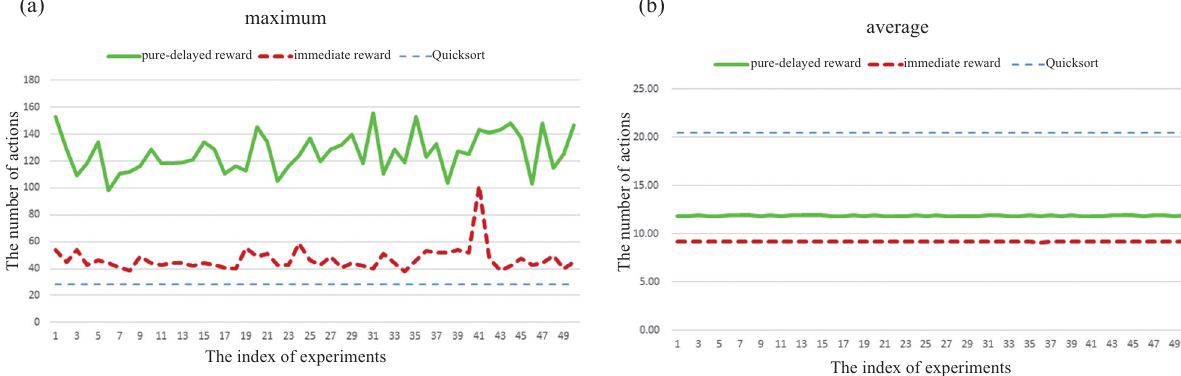
Fig. 7. Detailed results of maximum (a) and average (b) values to sort 8! lists for 50 times regarding pure­delayed reward, immediate reward, and